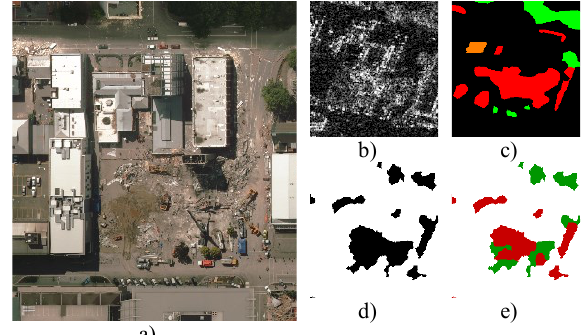
Figure 8 . Exemplary debris site: a) Optical image, b) SAR image, c) reference map, d) screening result, and e) classification result.